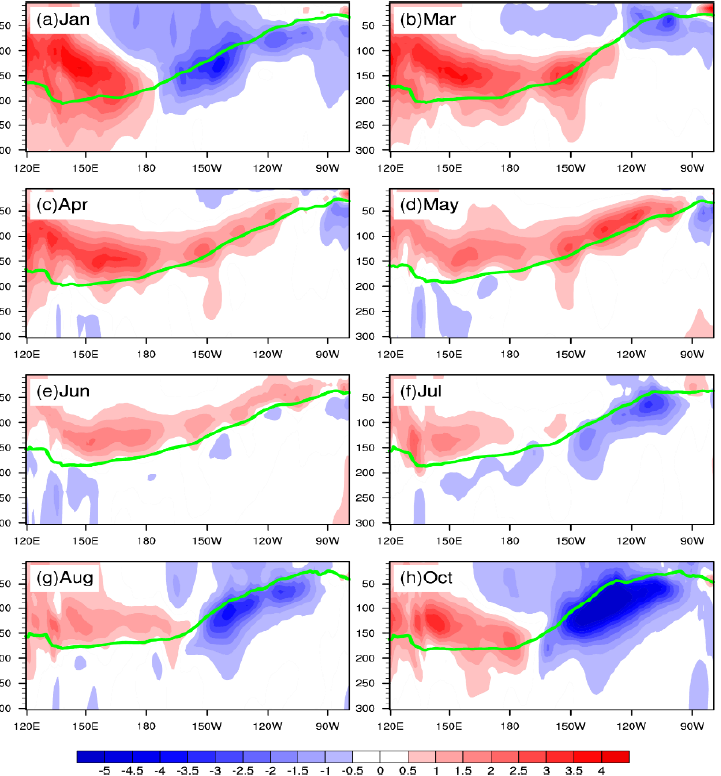
Figure 7. Zonal − depth sections of the equatorial Pacific (averaged at 2° S − 2° N) temperature anomalies (the upper 300 m) in January, March, April, May, June, July, August, and October 2021. The thermocline depth, defined as the 20 °C isotherm, is also shown (green line).